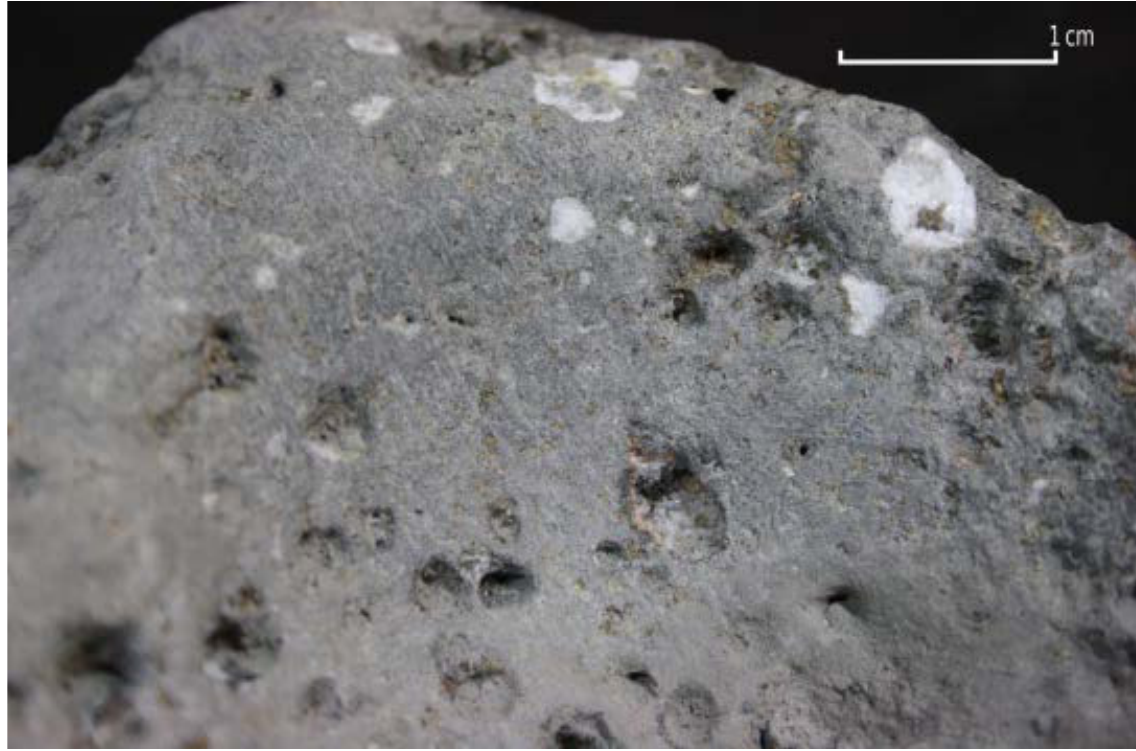
Figure 8. Close-up of the cavity side that was polished using the water and basalt powder